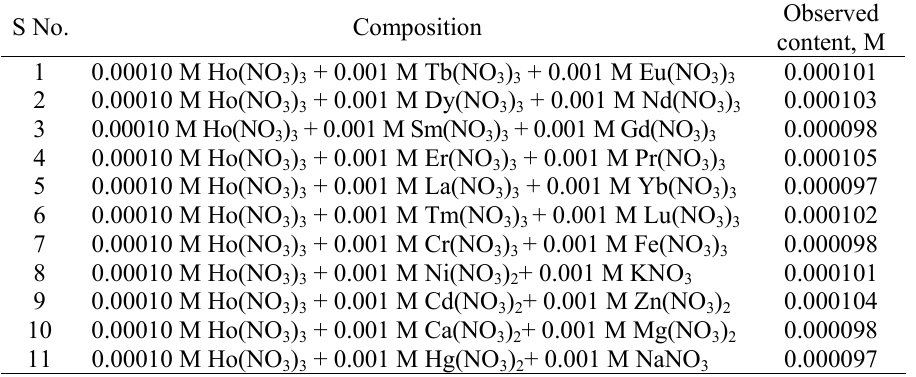
Table 3. Determination of Ho 3+ ions in mixtures of different